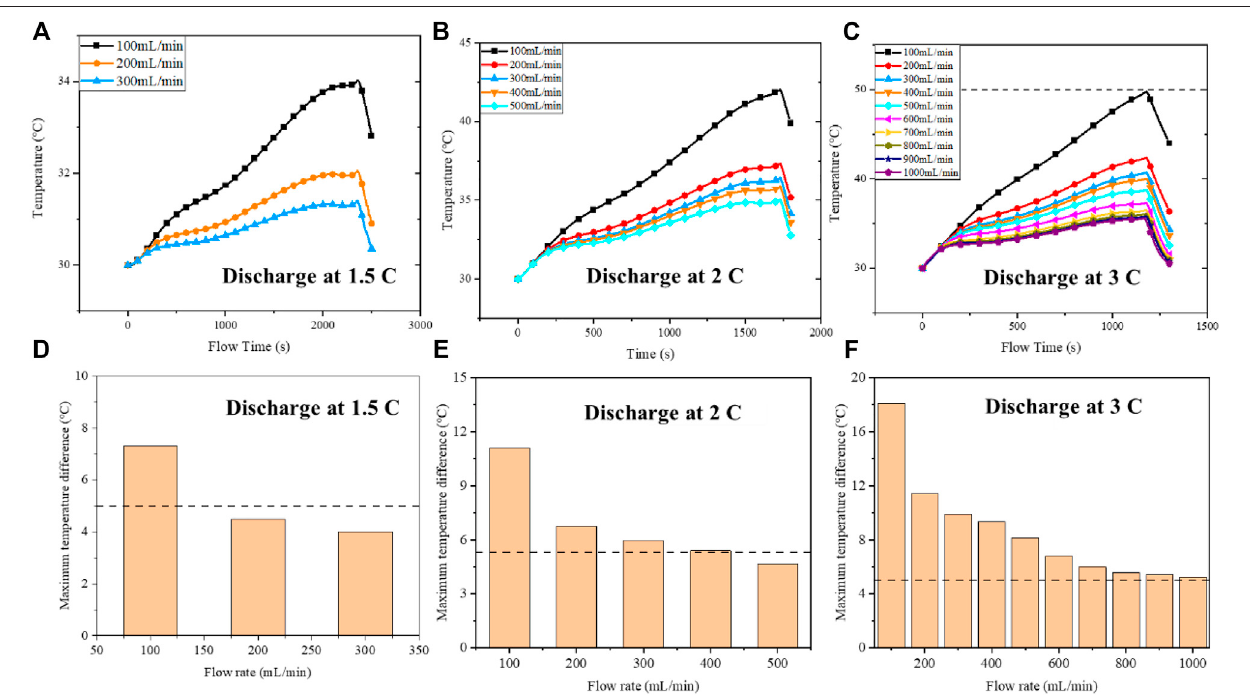
FIGURE 7 | Temperature (A – C) and maximum temperature difference (D – F) of the battery pack cooling at different fl ow rates.